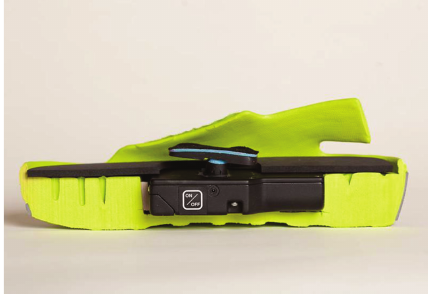
Figure 2: A lateral cross-section of the MMC sandal showing the embedded compression device in the sole. The pressure pad is in the elevated position.